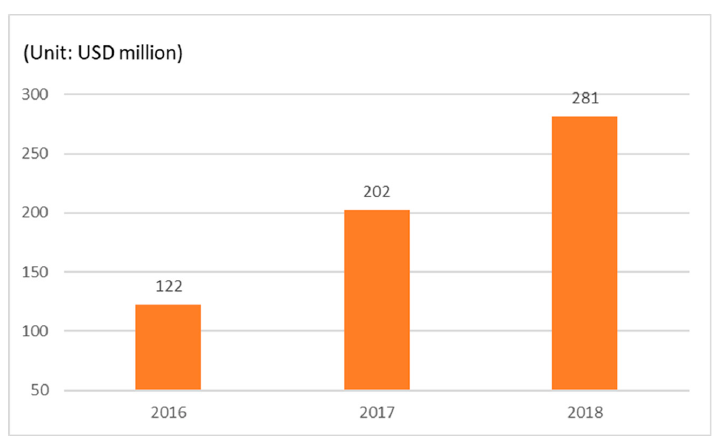
Figure 6. Loyalty Income (NCSoft, 2016–2018). Graph created by the authors. Source: [19].